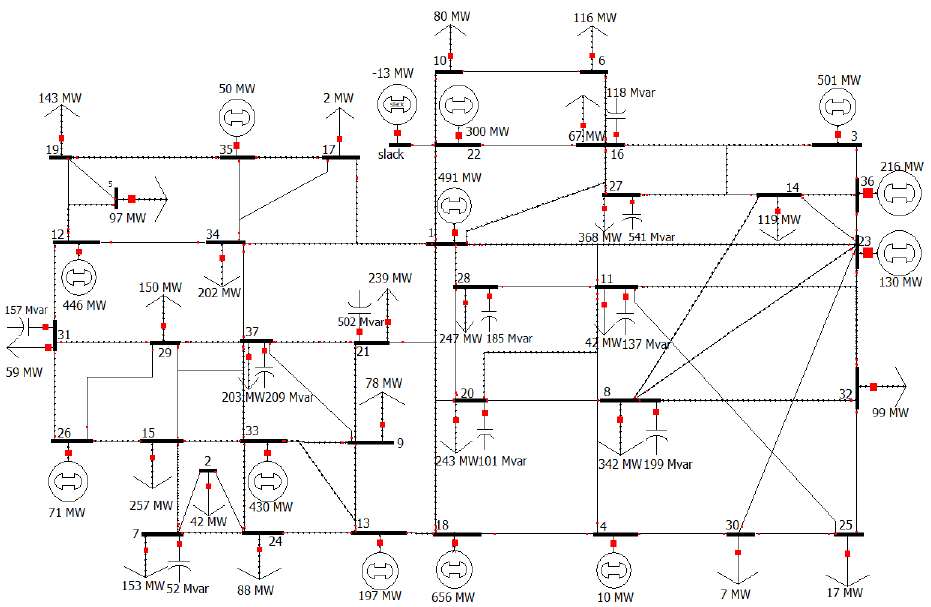
Figure 5. One-line diagram of the reduced 38-bus Korean power system. Table 2. Reduced Korean power system information.